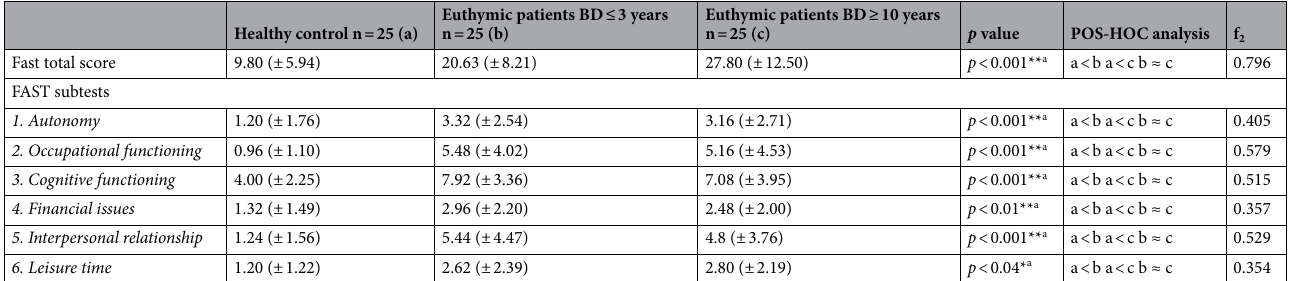
Table 5. Results of FAST substests in euthymic patients with ≤ 3 years and ≥ 10 years of the disease. Means ± standard deviation (SD). FAST = Functionality Assessment Short Test. n.s. = no significant a Kruskal– Wallis followed by Dunn´s post hoc to FAST test. [*] indicate FAST scores significantly different between groups. * p < 0.05 ** p < 0.001. f 2 = the overall Cohen’s effect size. This image was obtained with permission (IJAERS). Image origin: Cyrino et al., (2021). Assessment of different domain impairments in Cognitive Functions and Functionalities found in Euthymic Patients with Bipolar Disorder I/II—during the early and late phases of the disease, using the FAB and FAST tests. International Journal of Advanced Engineering Research and Science (IJAERS). 8, 401–433.